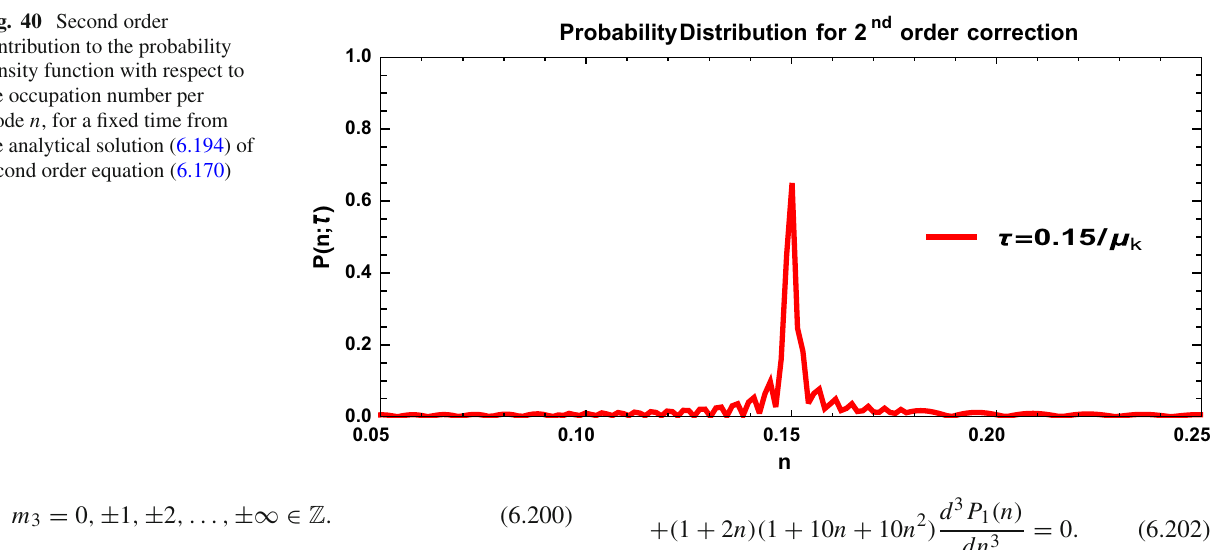
Fig. 40 Second order contribution to the probability density function with respect to the occupation number per mode n , for a fixed time from the analytical solution (6.194) of second order equation (6.170)